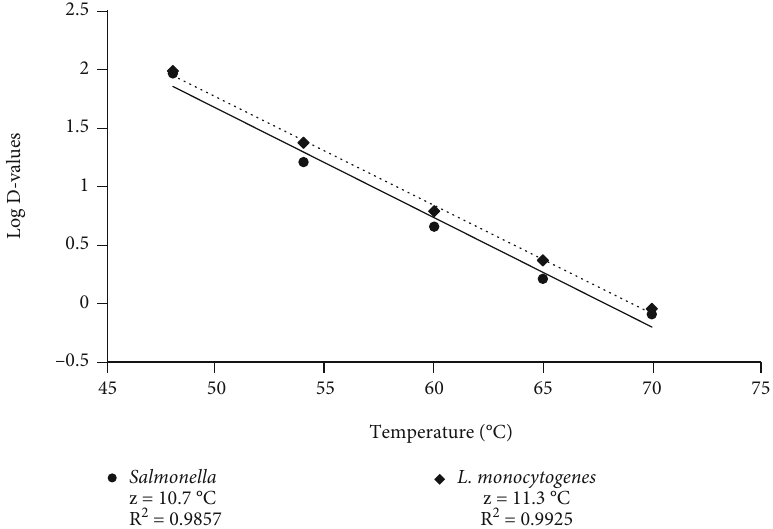
Maximum rate values are the mean ± standarddeviation of three replicated